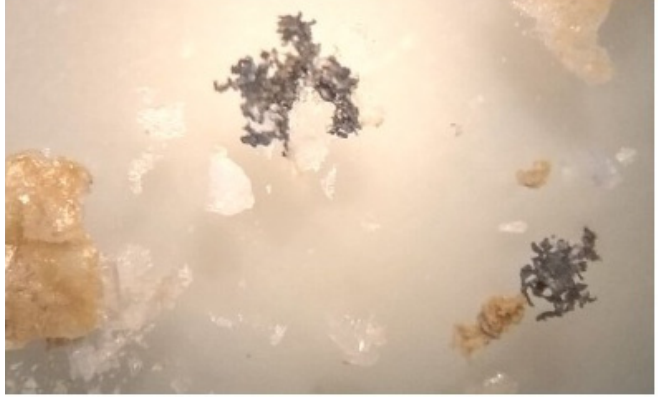
Figure 3. MPs shape under stereoscope with 20× magnification.